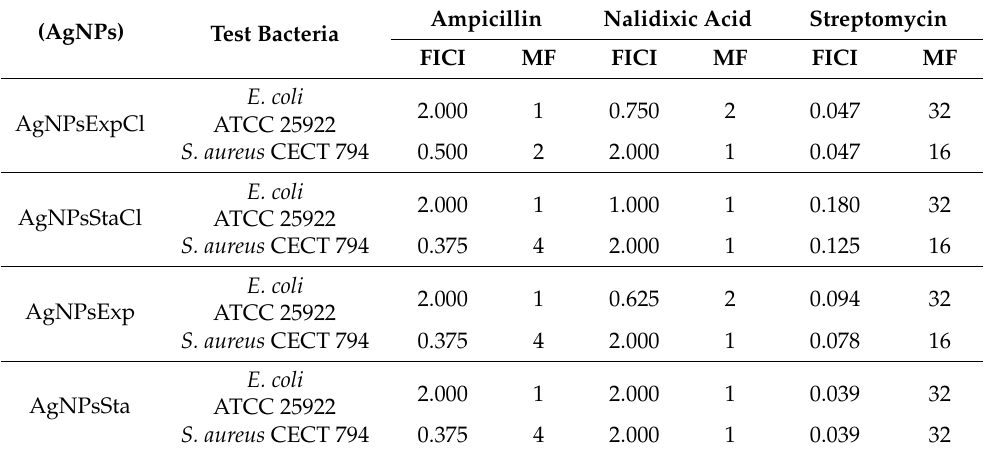
Table 3. Synergy effects of the AgNPs in combination with classic antibiotics against E. coli and S. aureus